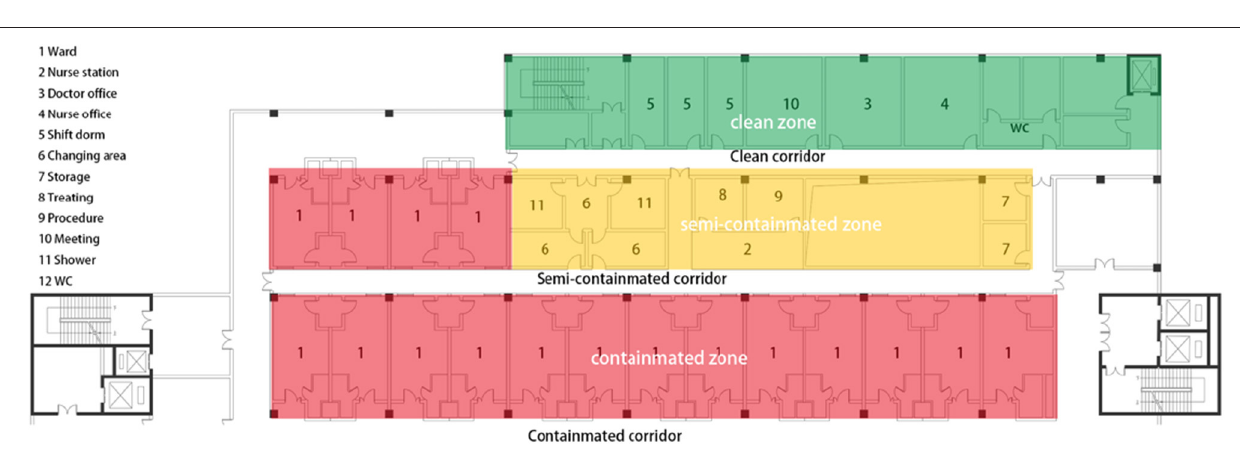
break areas (8), safety of workplace (6), and typology of nurse (3). In this IDNU, there were no independent break areas for nurses. The access of their workplace was restricted to the visitors